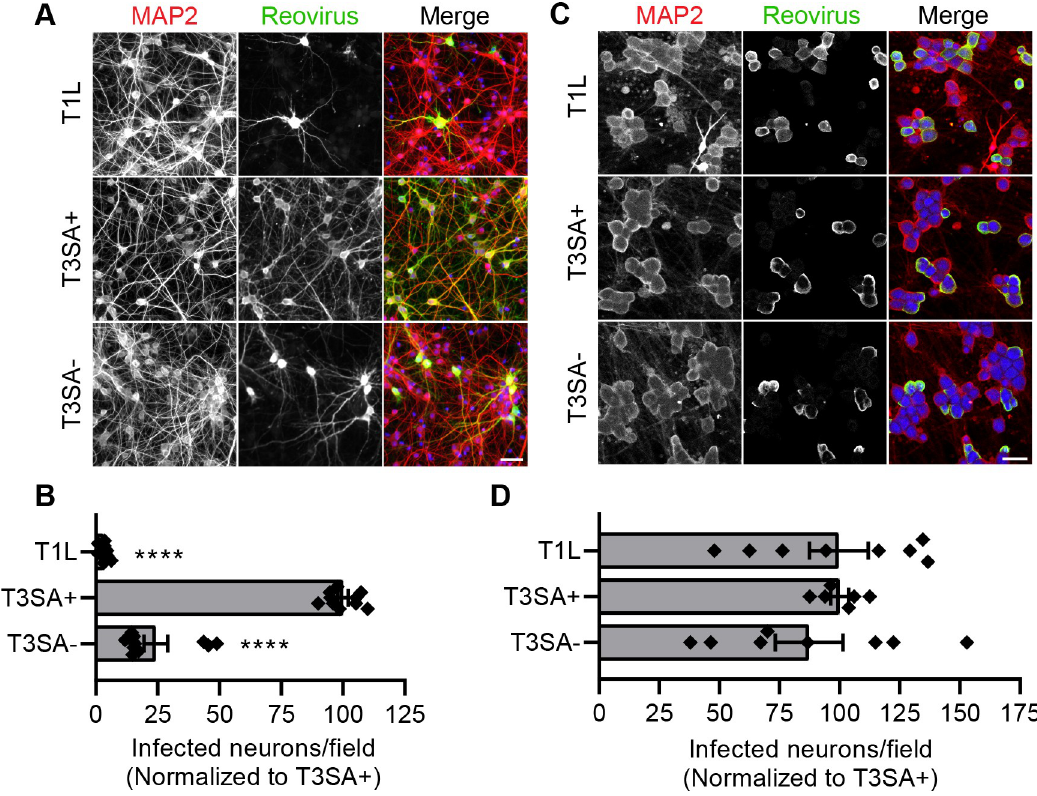
Fig 1. Serotype-dependent reovirus infection in vivo is reproduced in primary neuron cultures. Cultured rat cortical neurons (CNs) or dorsal root ganglion neurons (DRGNs) were adsorbed at an MOI of 500 or 50 PFU per cell, respectively, with the reovirus strains shown, and cells were fixed at 24 h post-adsorption. (A, C) Neurons were immunostained using an antibody to detect a neuronal protein (MAP2) and reovirus-specific antiserum. Nuclei were stained with DAPI (blue). Representative micrographs display infected CNs (A) or DRGNs (C). Scale bars, 50 μ m. (B, D) Infectivity of CNs (B) or DRGNs (D) was scored as the mean number of cells stained by reovirus antiserum per field-of-view. Bars indicate means from at least three independent experiments, each with duplicate or triplicate samples, normalized to T3SA+ infectivity. For reference, ~ 26% of CNs are infected by T3SA+ reovirus under the experimental conditions used.) Error bars indicate SEM. Individual data points are normalized averages from 8 to 12 fields-of-view from each sample. Values that differ significantly from T3SA+ by ANOVA and Dunnett’s test are indicated ( ���� , P < 0.0001).